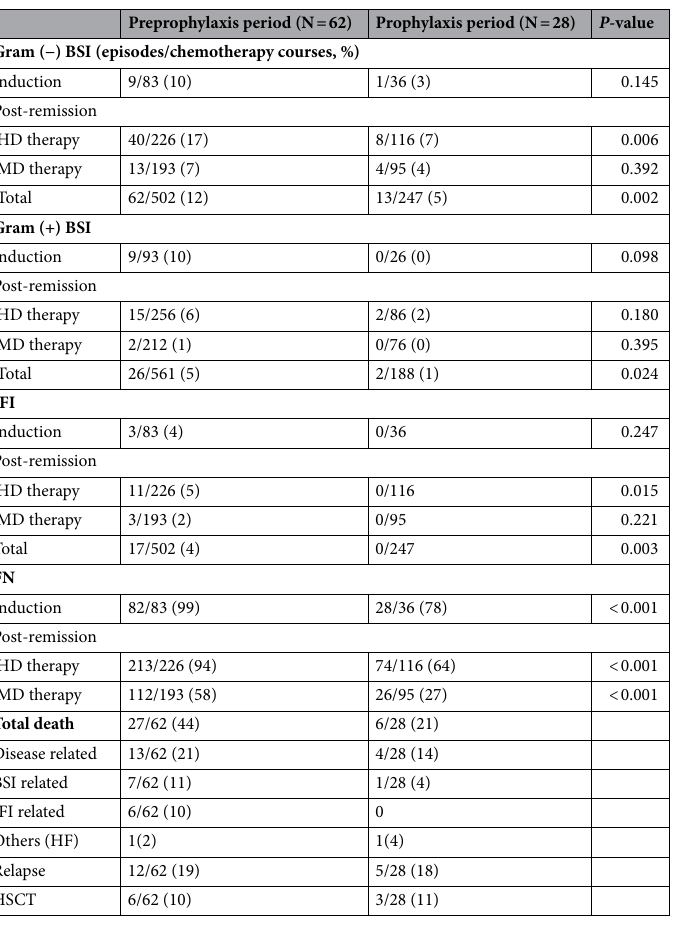
Table 2. The rates of BSI, IFI or FN are presenting as the proportion of the total number of BSI, IFI or FN in the course of chemotherapy between the preprophylaxis and prophylaxis period. BSI, bloodstream bacterial infection; FN, febrile neutropenia; HD, high-dose; HF, heart failure; HSCT, hematopoietic stem cell transplantation; IFI, invasive fungal infection; MD, modest-dose; N,